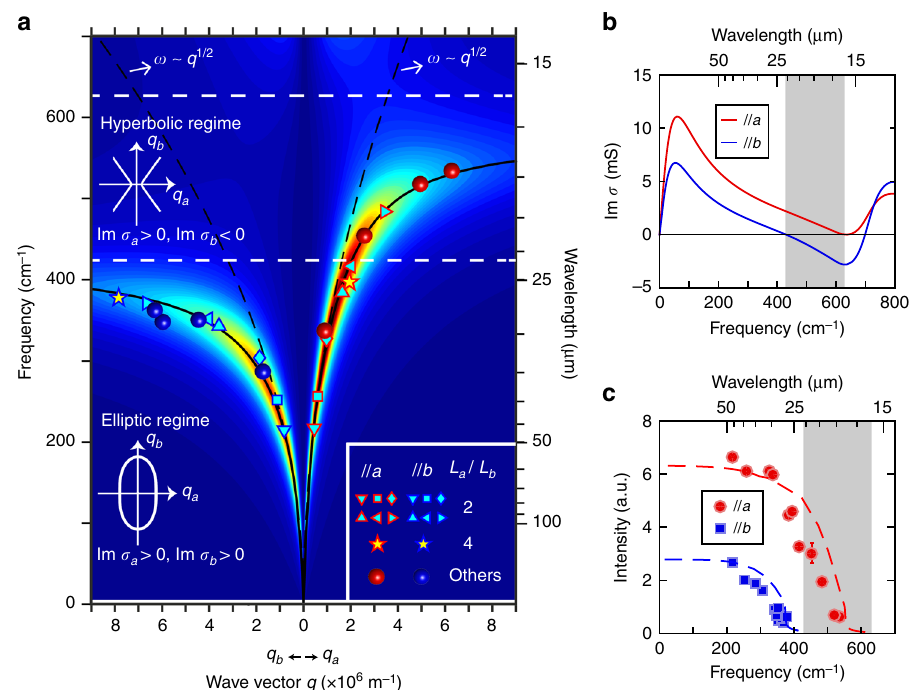
Fig. 4 Plasmon dispersion along the two principal axes. a Plasmon dispersion for polarization along a and b axes measured in rectangle arrays. The calculated loss function is displayed as a pseudocolor map. The solid and dashed black curves represent the fi tted dispersion with/without considering the interband transitions based on the loss function results. Dashed horizontal white lines are plotted to represent the hyperbolic regime obtained from the loss function calculation. Insets are schematics of the isofrequency contours of the plasmon in the hyperbolic and elliptic regimes. See Supplementary note III for details. b Imaginary parts of the conductivity along a and b axes calculated by the loss function. c Intensity of plasmons along a and b axes in ( a ) as a function of the plasmonic resonance frequencies. Error bars are de fi ned from fi ttings. The fi lling factors and fi lm thickness have been taken into account. The dashed curves are fi ttings by the coupled oscillator model. All the shaded areas indicate the hyperbolic